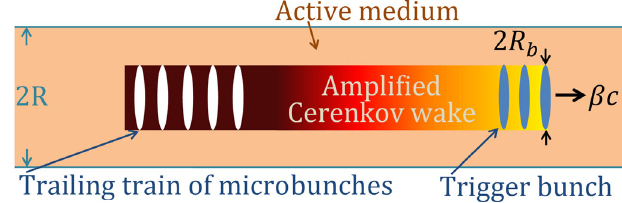
FIG. 1. Schematic description of the AM-TBA for accelerating a trailing train of microbunches that is located at the saturation